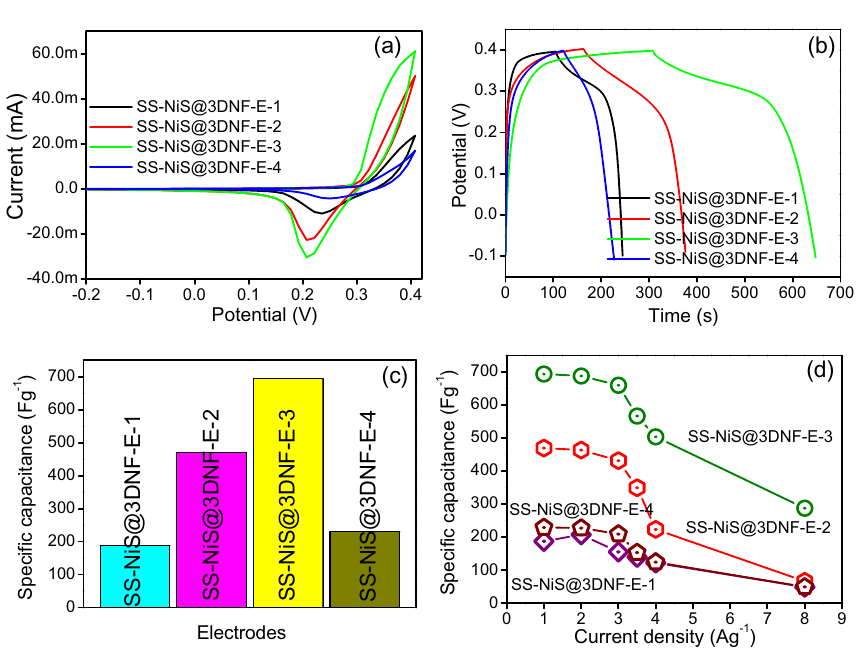
Figure 5. ( a ) Comparative CV graph of the SS-NiS@3DNF-E-1, SS-NiS@3DNF-E-2, SS-NiS@3DNF-E-3, and SS-NiS@3DNF-E-4 electrodes., ( b ) comparative GCD graph of the SS-NiS@3DNF-E-1, SS-NiS@3DNF-E-2, SS-NiS@3DNF-E-3, and SS-NiS@3DNF-E-4 electrodes., ( c ) comparative specific capacitance bar graph of the SS-NiS@3DNF-E-1, SS-NiS@3DNF-E-2, SS-NiS@3DNF-E-3, and SS-NiS@3DNF-E-4 electrodes., and ( d ) specific capacitance at different current densities of the SS-NiS@3DNF-E-1, SS-NiS@3DNF-E-2, SS-NiS@3DNF-E-3, and SS-NiS@3DNF-E-4